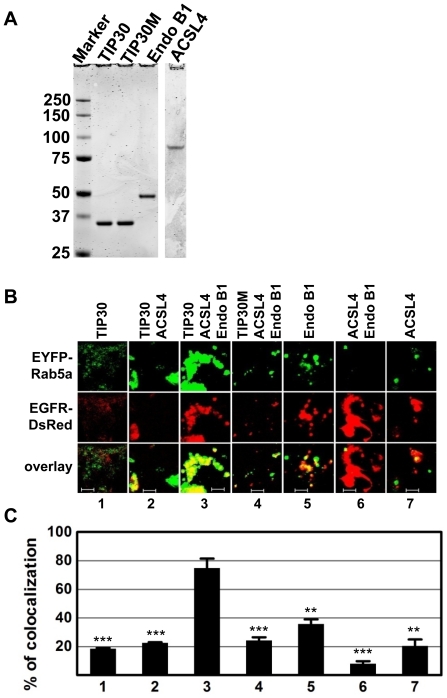
Bacterially expressed recombinant TIP30, ACSL4 and Endo B1 can replace the TIP30 complex in promoting efficient vesicle fusion.(A) Recombinant proteins were expressed in BL21 cells and were purified using cobalt affinity resins. Eluted proteins were subjected to SDS-PAGE analysis followed by Coomassie blue staining. Images were acquired using a Li-Cor scanner. (B) EGFR-DsRed and EYFP-Rab5a vesicles were incubated with the indicated recombinant proteins (20 ng each) in the fusion buffer. Resulting fusion products were examined using confocal microscope. Scale bars, 5 µm. (C) Quantification of images represented in (B). Signal overlap was quantified using MBF_ImageJ. Pearson's colocalization coefficients were calculated from three independent experiments and converted to percentages. Data represent means ± SEM. **P<0.01, ***P<0.001; t test.